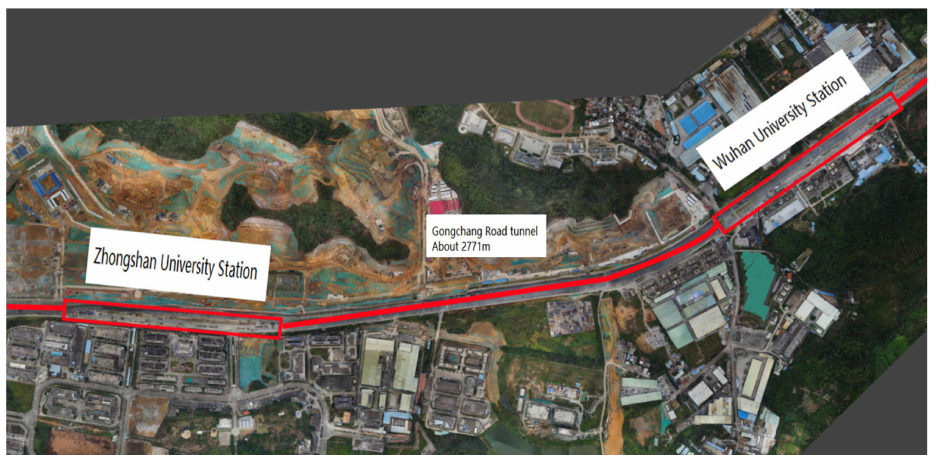
Figure 2. Geomorphic map near construction